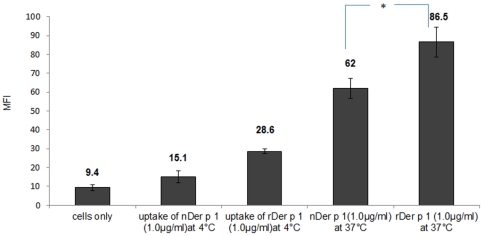
MFI ± SEM readings which represent the difference in uptake between natural and recombinant Der p 1 (1 µg/ml) by immature DCs.There was a significant difference between natural and recombinant allergen uptake. The results suggest that the average mean of uptake for the recombinant preparation is higher than that for natural Der p 1. The results also show that the uptake of Der p 1 by immature DCs at 4°C is lower than the uptake at 37°C for both preparations. Both natural and recombinant Der p 1 were labelled with FITC. *P value<0.05.